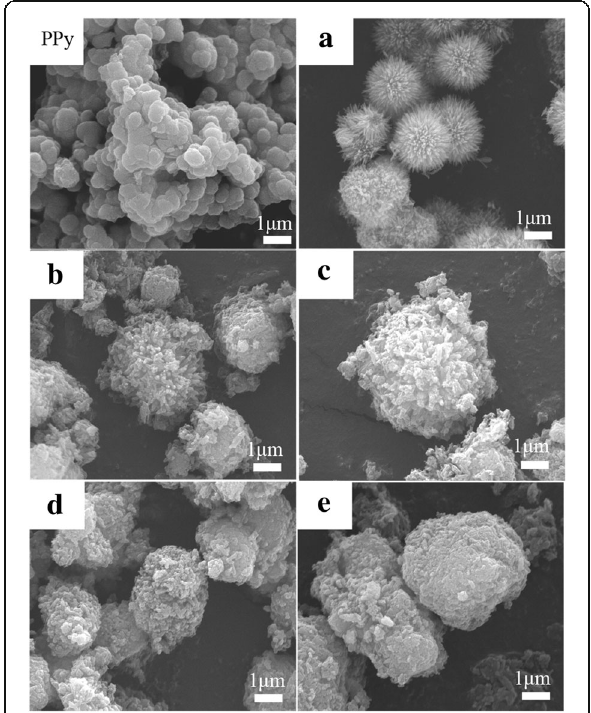
Fig. 1 SEM images of PPy coated urchin-like MnO 2 sample. In the top left-hand corner is pure PPy, a urchin-like MnO 2 sample, b 10 μ L, c 20 μ